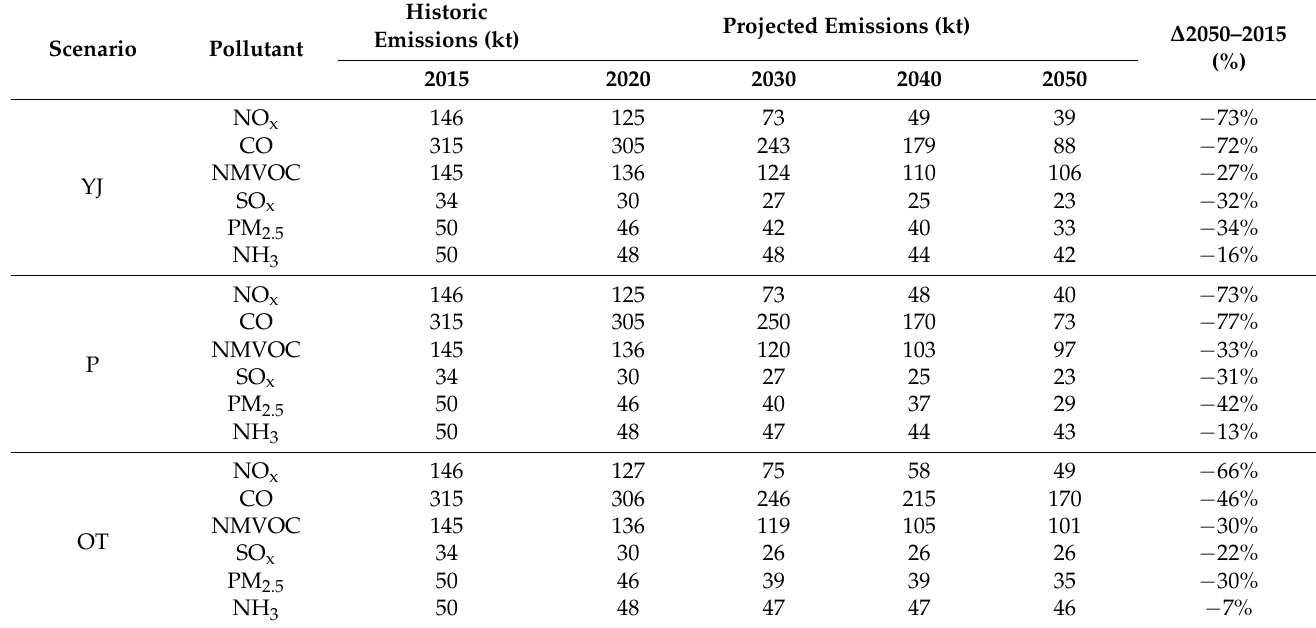
Table 1. Air pollutant emission estimates for three scenarios (YJ, P, and